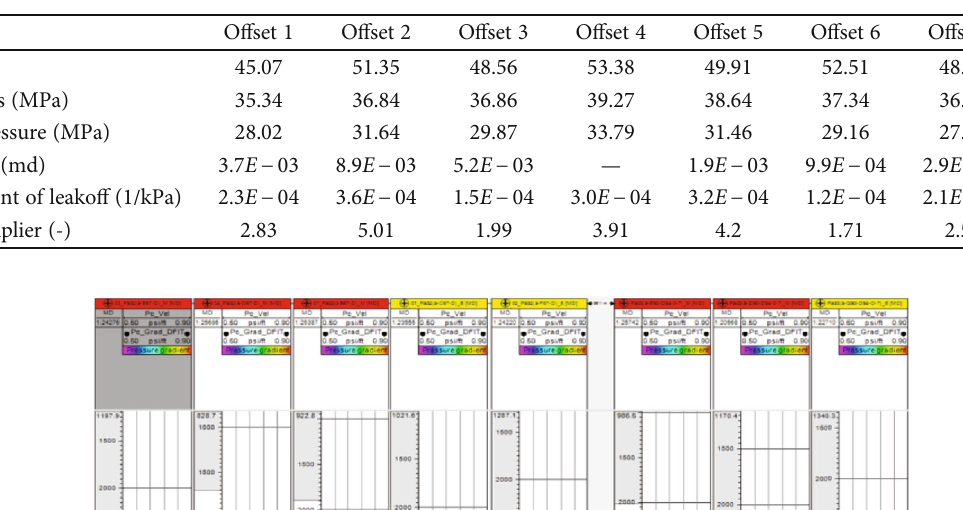
Table 1: DFIT analysis